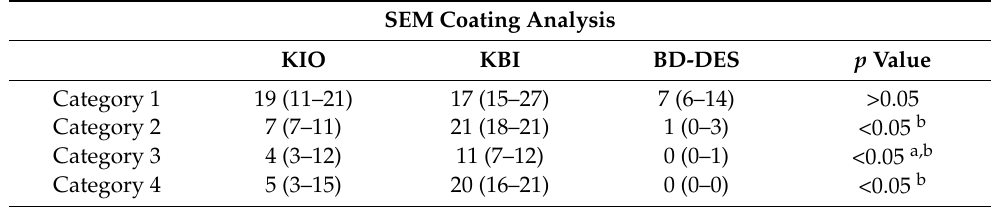
Table 2. SEM analysis of polymer coating damage ( n = 5).